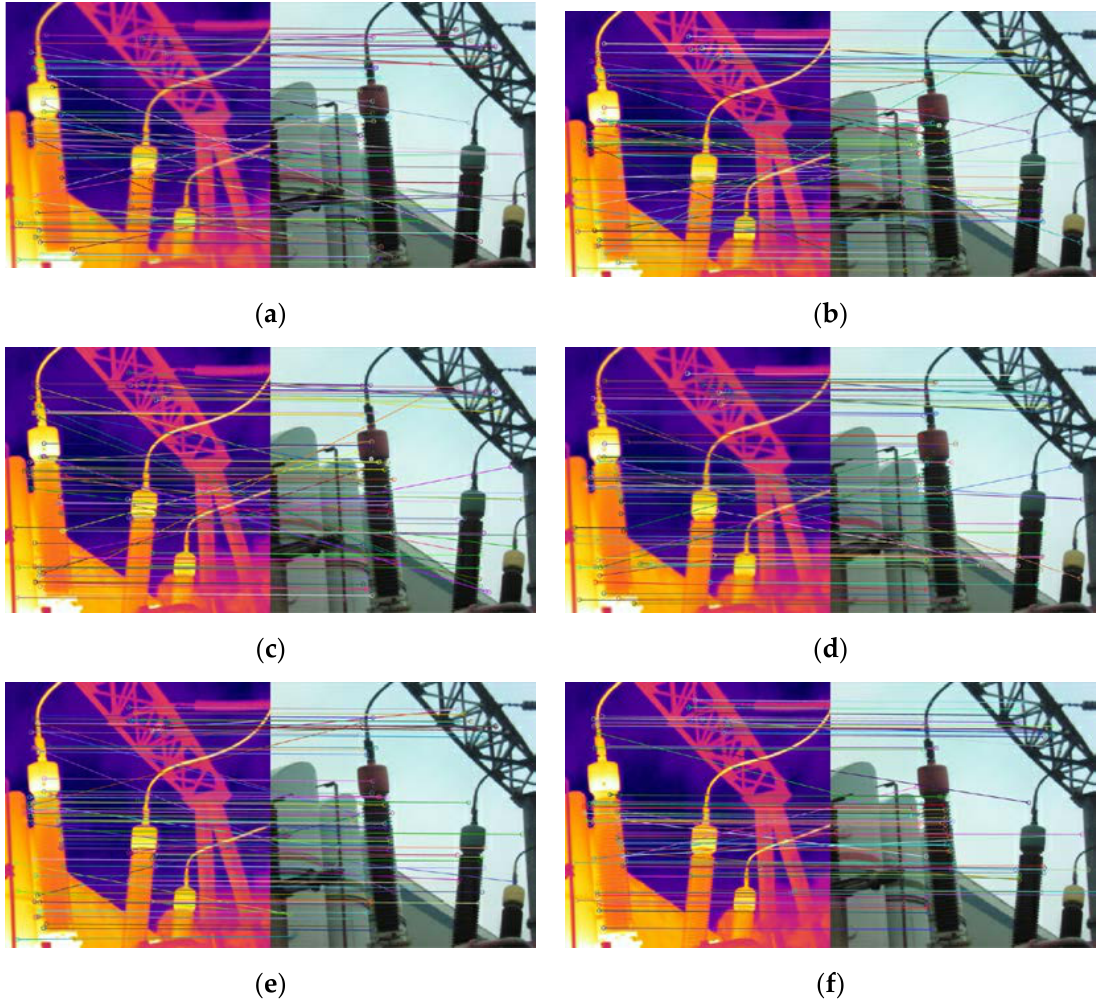
Figure 6. Feature point matching results of infrared images reconstructed by different methods ( a ) LR ( b ) Keys’ ( c ) Shao’s ( d ) Li’s ( e ) Kim’s ( f ) Ours. Table 3. The number of feature points detected in images reconstructed by different methods.